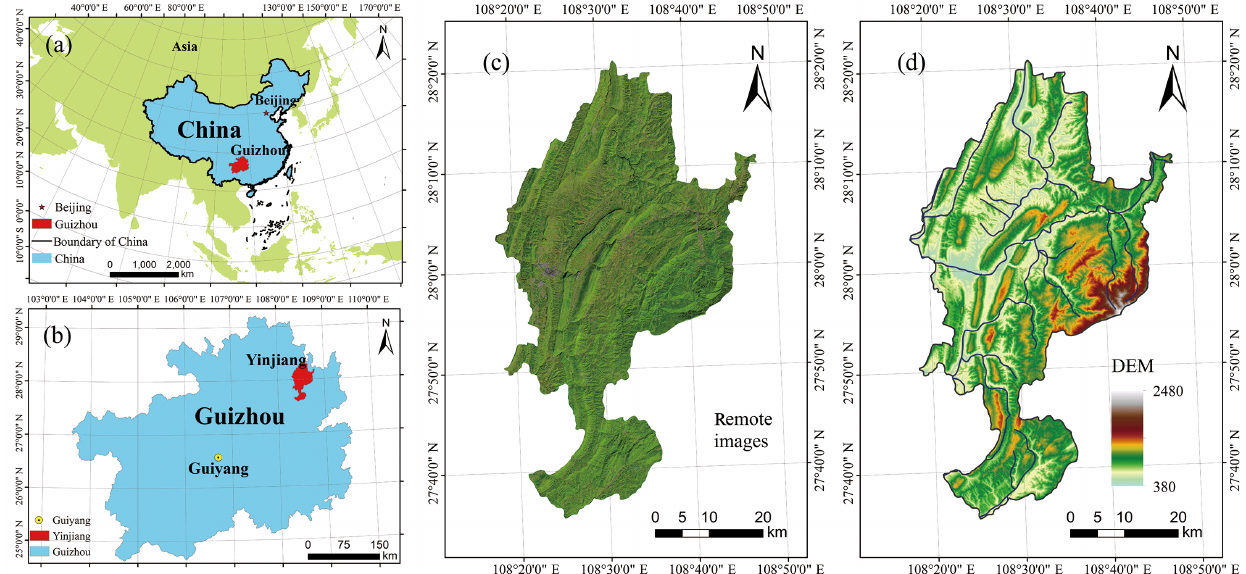
Figure 1. Study area in Guizhou, China (a, b) . Study area remote images (c) and topography (d) .